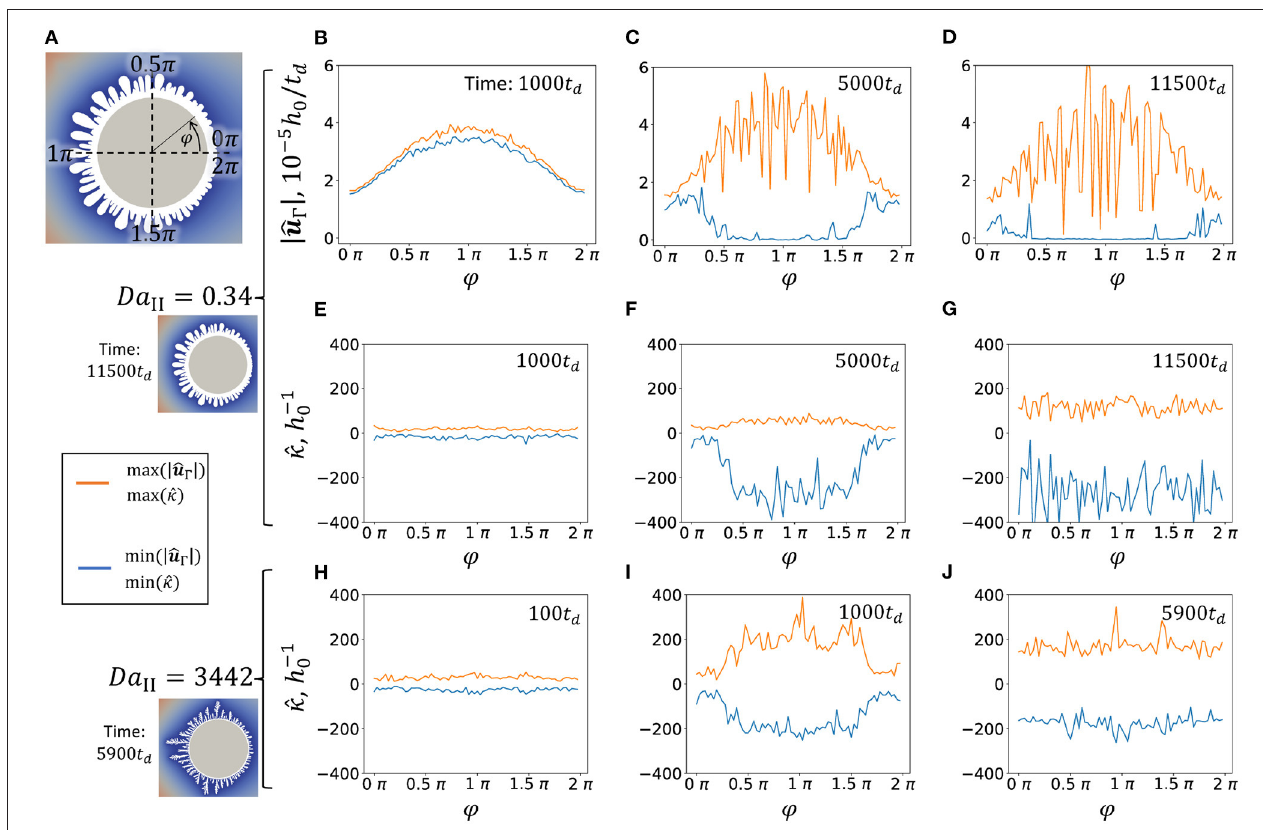
FIGURE 6 | Maximum and minimum of surface velocity magnitude, |ˆ uuu Ŵ | , and surface curvature, ˆ κ , distribution along angular coordinate ϕ at flow rate Pe = 7.14. (A) Schematics of angular coordinate ϕ definition. (B–D) max( |ˆ uuu Ŵ | ) and min( |ˆ uuu Ŵ | ) at different simulation times ( Da II = 0.34). (E–G) max( ˆ κ ) and min( ˆ κ ) at different simulation times ( Da II = 0.34). (H–J) max( ˆ κ ) and min( ˆ κ ) at different simulation times ( Da II = 3442). Little snapshots on the right demonstrate the shape of precipitate at corresponding Da II at the later simulation times.